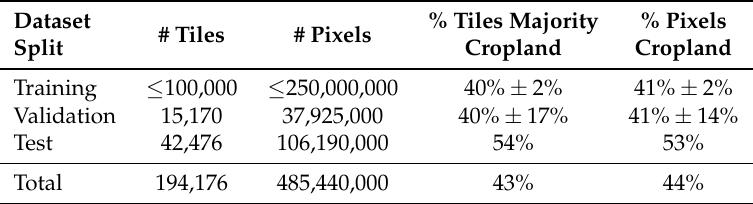
Table 1. Summary statistics for the US Midwest